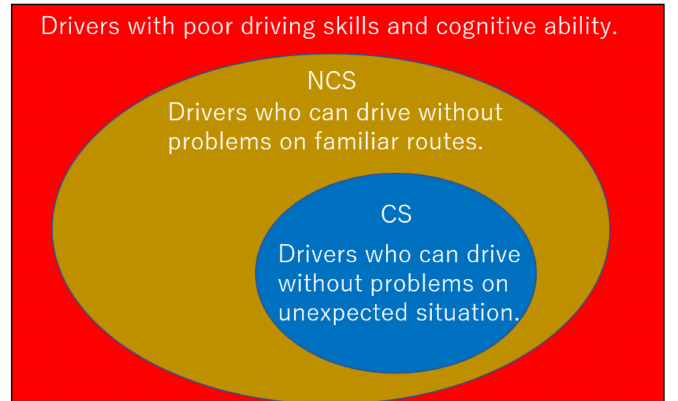
Figure 1. The Venn diagram of those with coping skills (CS) and without coping skills (NCS).